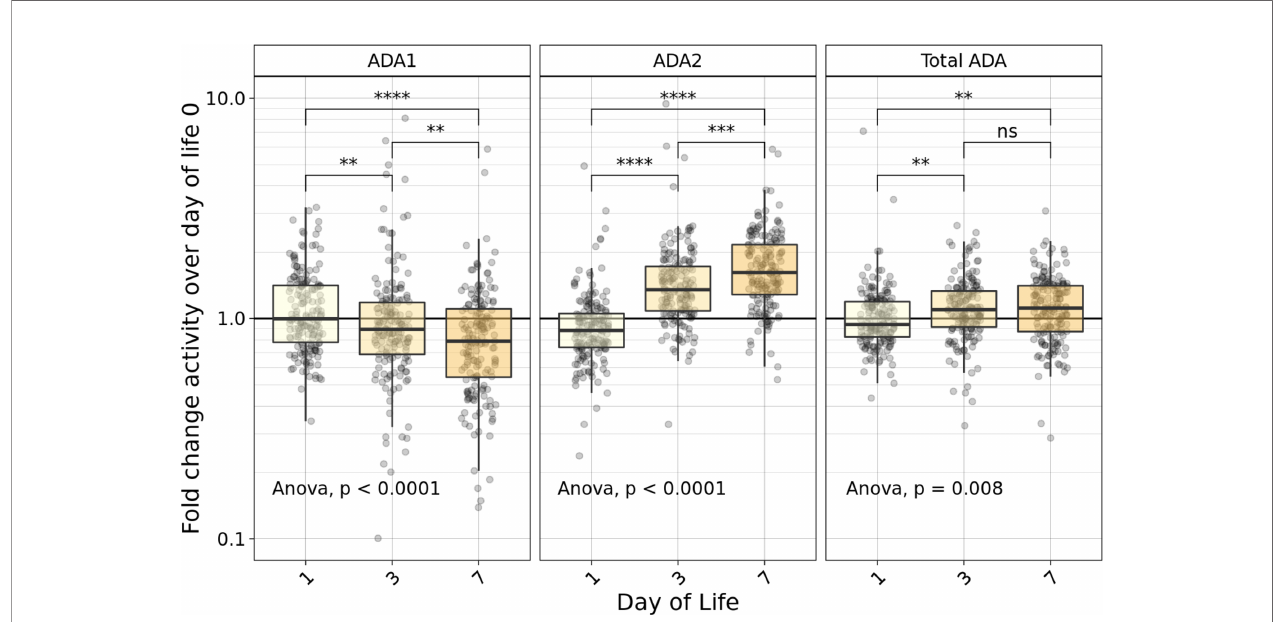
FIGURE 2 | Fold-change relative to DOL0 of ADA concentrations measured in plasma during the fi rst week of life varied based on type of ADA measured. Fold- change of ADA1 (left), ADA2 (middle) and Total ADA (right) plasma concentrations relative to the day of life (DOL) 0 in the Gambian cohort demonstrated an increase in relative plasma ADA2 and total ADA, as well as a decrease in ADA1 across the fi rst week of life (n =168-173/group). Statistical analyses employed ANOVA followed by Welch ’ s t-test for pairwise comparisons. Signi fi cant p-values depicted as **p<0.01, ***p<0.001; ****p<0.0001; ns, not signi fi